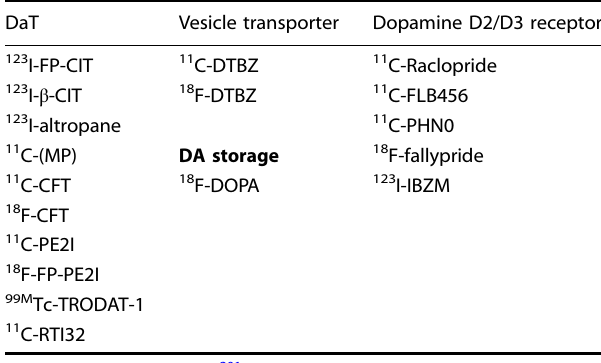
Table 9. Radiotracers available in investigating dopaminergic pathophysiology in